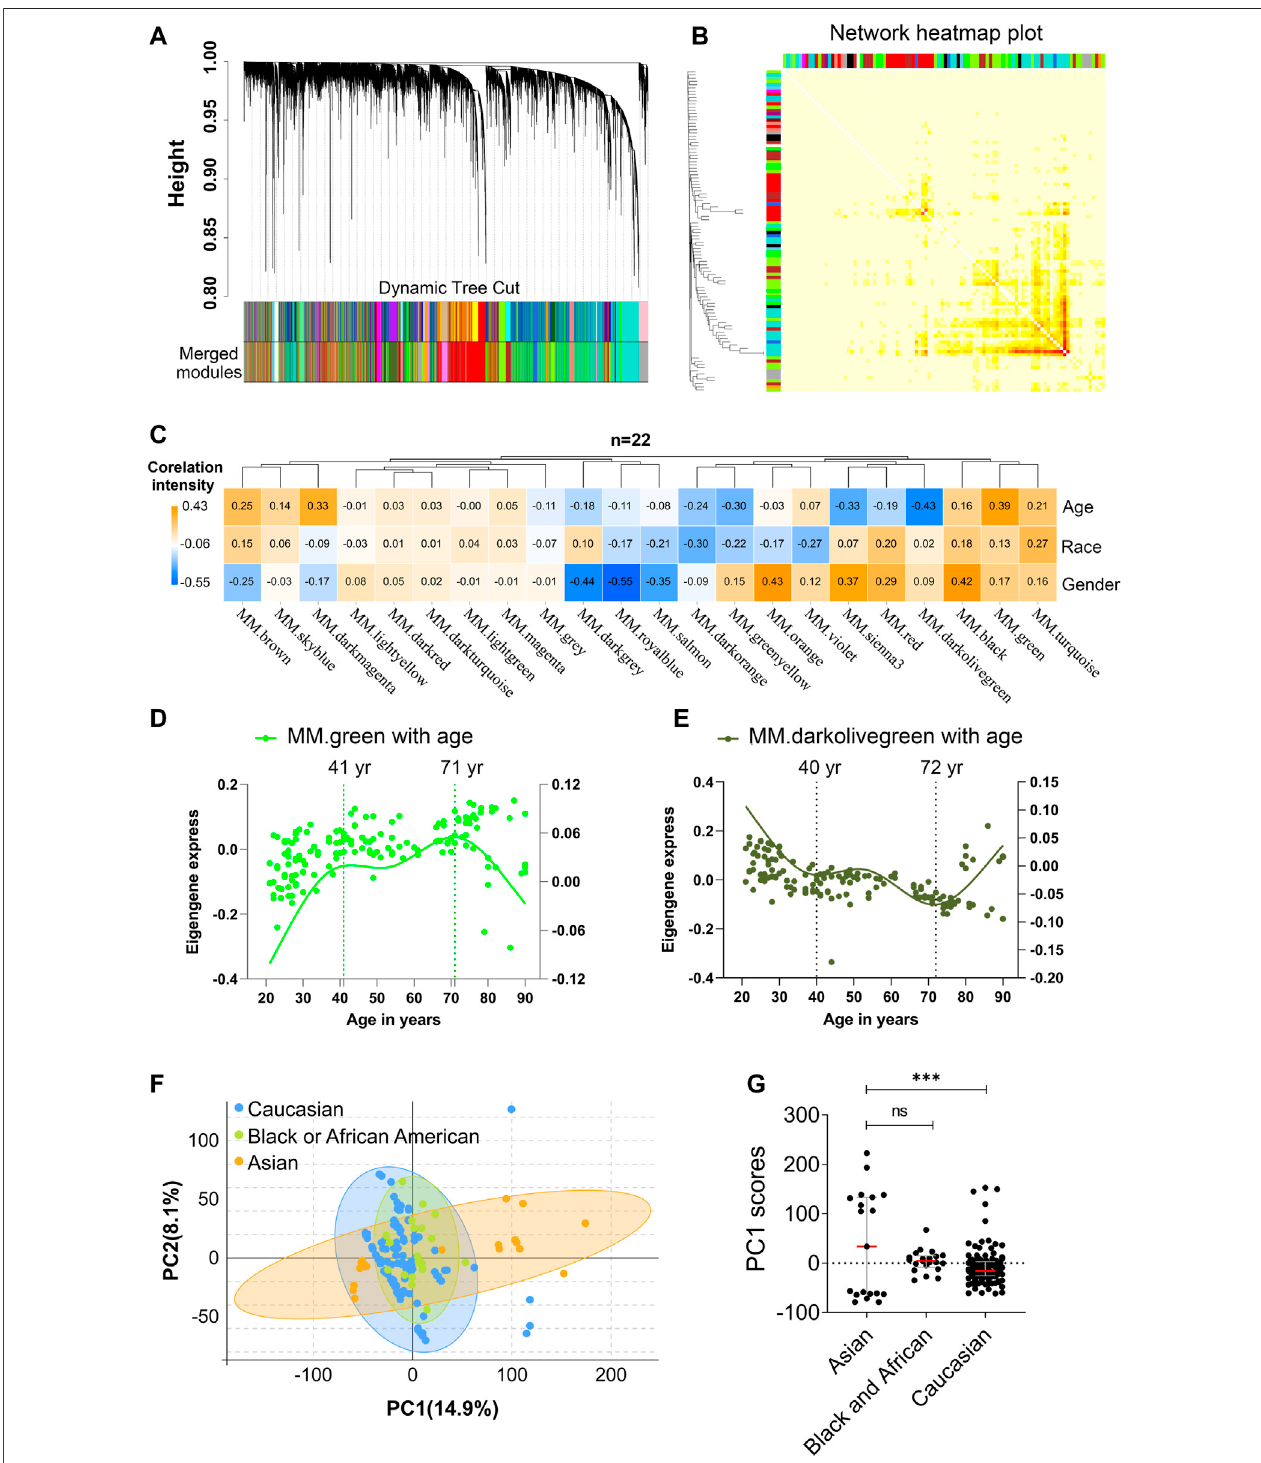
FIGURE 2 | Age and race in fl uenced the transcriptomic variations over human adult lifespan. WGCNA approach was applied for gene module construction for the transcriptome data of 153 healthy human subjects in 10KIP. Principal component analyses (PCA) were calculated individually. (A) Cluster dendrogram. Each branch represented one gene, and each color below denoted one co-expression gene module. The two colored rows below the dendrogram represented the original and merged modules, respectively. (B) Eigengene adjacency heatmap of different modules. Each module showed independent validation to each other, and higher correlation indicated higher co-expression interconnectedness. (C) Heatmap of the Pearson ’ s correlation coef fi cient between trait (age, race and gender) and module